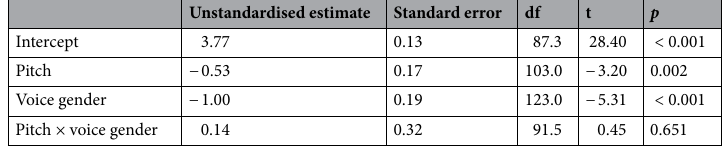
Table 7. Results of our analysis of dominance ratings in Study 2.